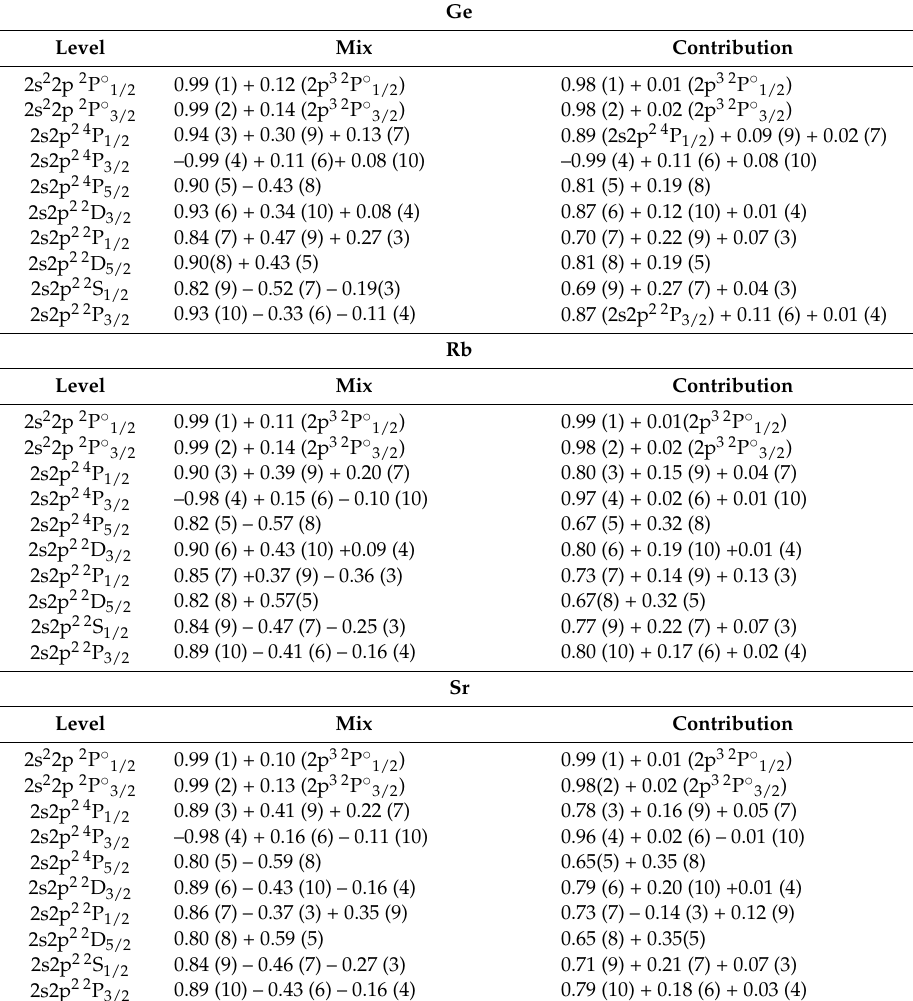
Table 2. The configuration mixing coefficients and contributions for levels in B-like ions. The number in parenthesis refers to the level